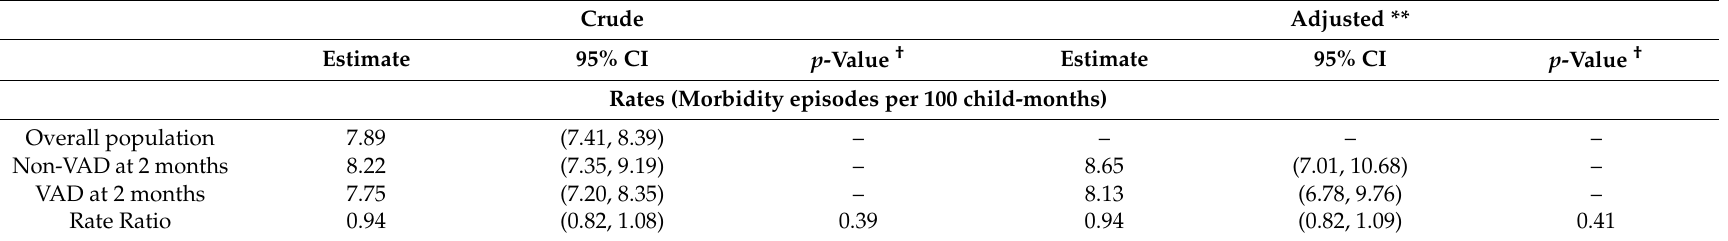
Table 4. Effects of early vitamin A deficiency (VAD; RBP < 0.70 µ mol/L) on rates of reported morbidity episodes ( N = 330)